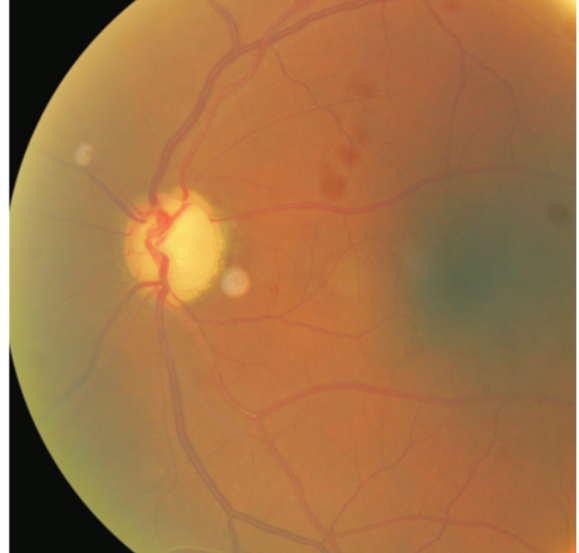
Figure 1. Suspected glaucoma in 53 year-old habitual wearer of ready-made